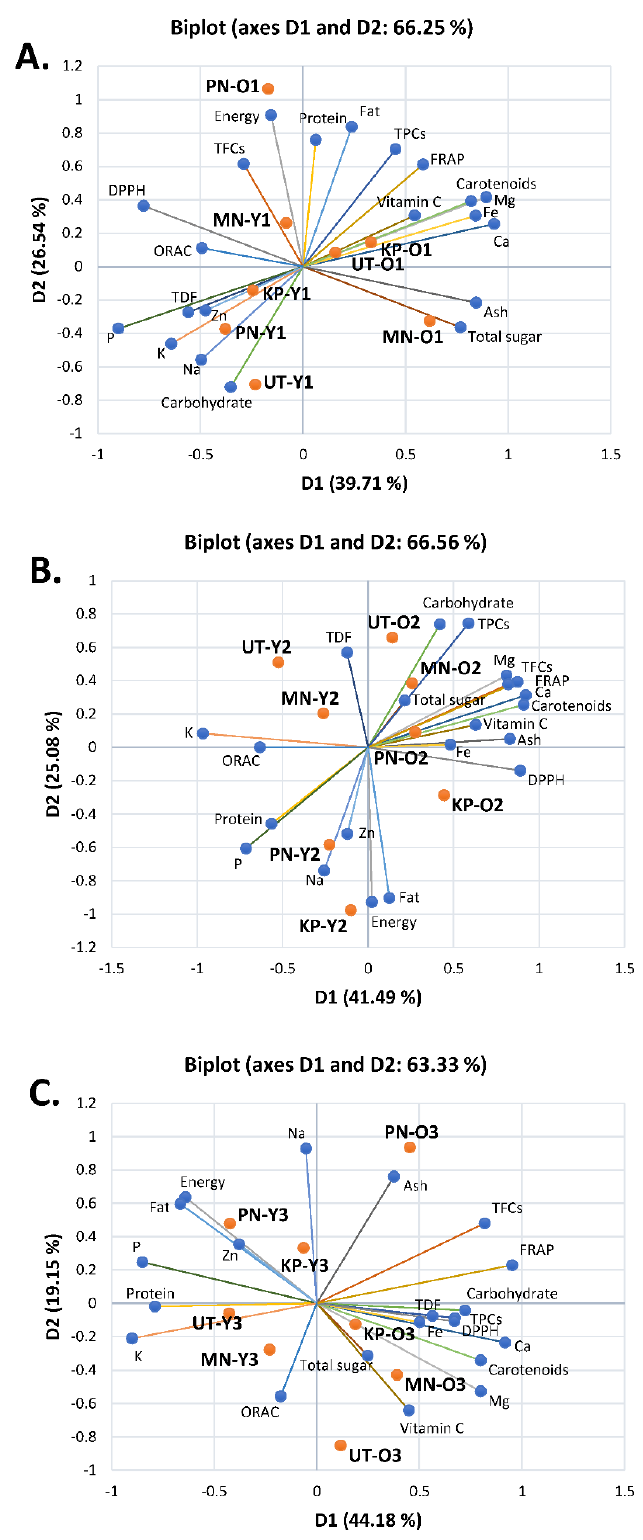
Figure 2. Biplot of Principal Component Analysis (PCA) derived from mean of nutritive values, total phenolic contents, total flavonoid contents, and antioxidant activities in young shoots (Y) and old leaves (O) of Adenia viridiflora Craib. from different origins including Kamphaeng Phet (KP), Muang Nakhon Ratchasima (MN), Pakchong Nakhon Ratchasima (PN), and Uthai Thani (UT) collected in different harvesting periods including ( A ) March–April (1); ( B ) May–June (2); and ( C ) July–August (3).